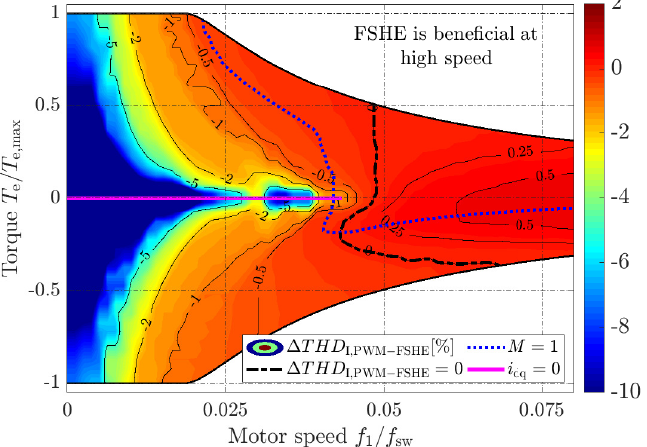
Figure 11. Obtained simulated, absolute difference in current THD I between multilevel PWM and FSHE, ∆ THD I,PWM − FSHE